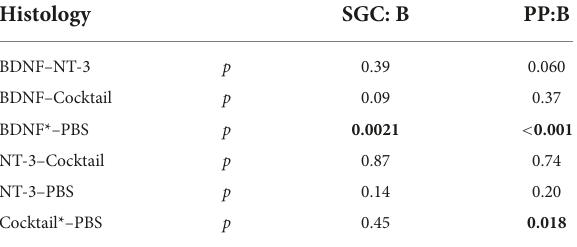
TABLE 3 P -values for Tukey‘s pairwise comparison following ANOVA as post hoc of the linear mixed model, performed over the log 2 transformed ratio between the treated and untreated